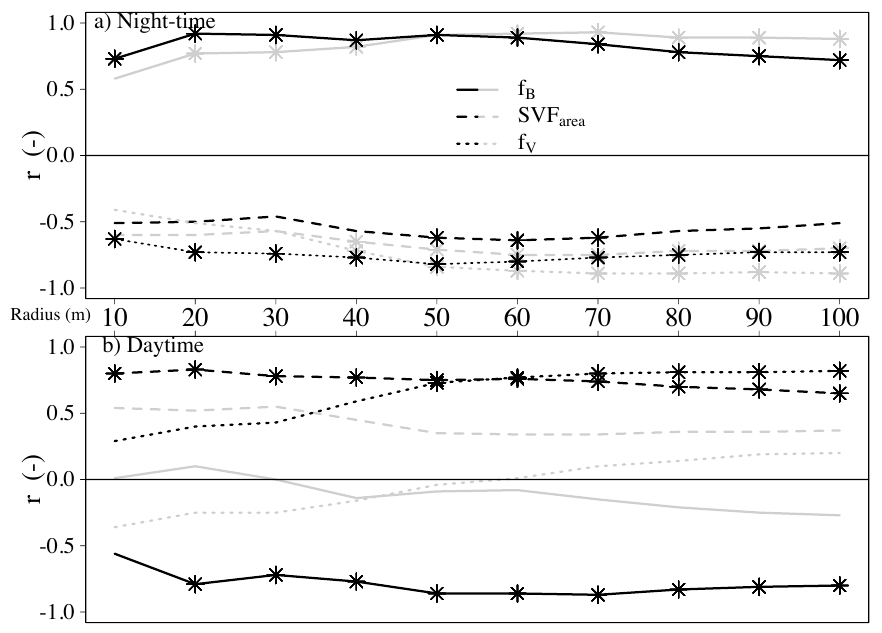
Figure A1. ( a ) Correlation coefficient r between night-time mean air temperature within the study area and different morphometric parameters over different radii. Black lines: nights with east wind; grey lines: all nights. ( b ) Same as ( a ) but for daytime. Black lines: clear, calm, dry day (24 June 2016); grey lines: all days. Stars indicate significant correlations ( p <